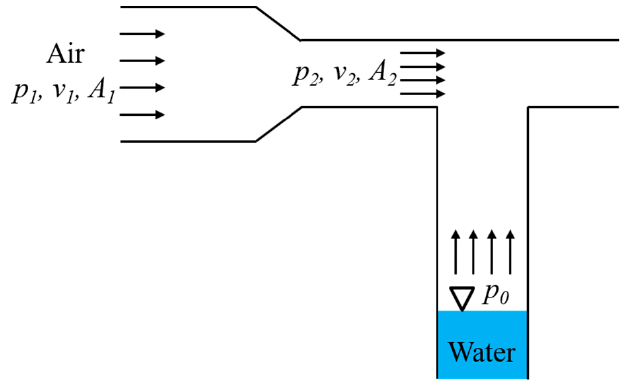
Figure 1. Schematics of a jet pump.